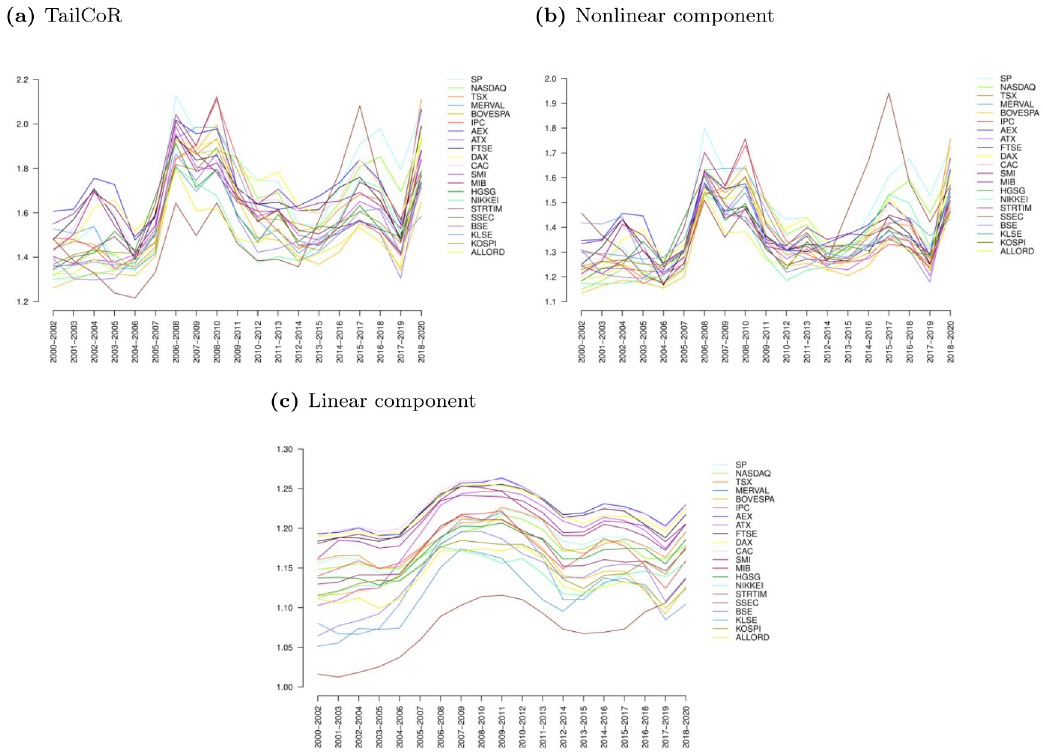
Fig 11. TailCoR and its components. Panel (a) shows the evolution of TailCoR for all market indexes. Each line is the cross- sectional average of one market index with respect to the others. Panels (b) and (c) show the evolution of the nonlinear and linear components